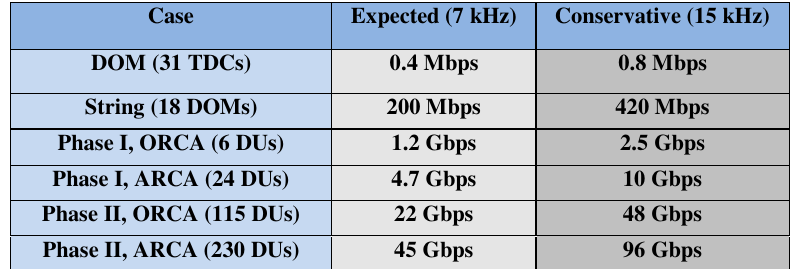
Table 1. The TDC throughputs for different stages of KM3NeT for an expected and a conservative estimate of the PMT hit